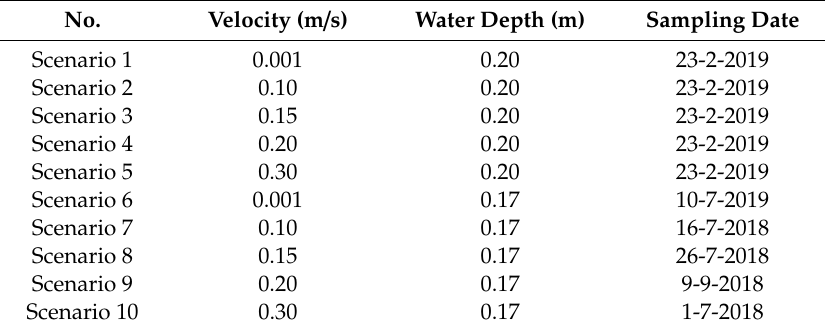
Table 1. Conditions in the experimental